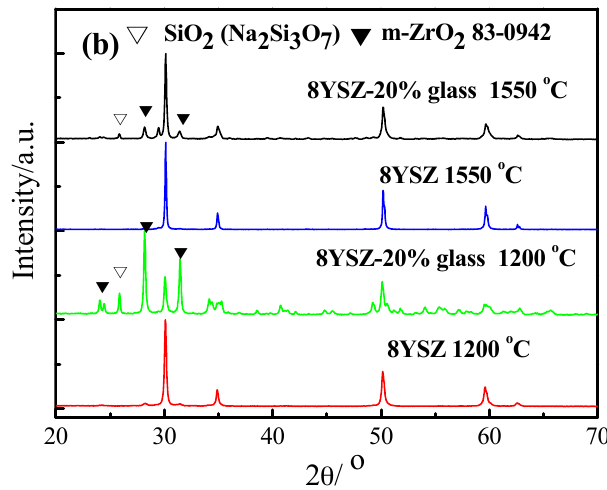
Figure 2. ( a ) XRD patterns of the 8YSZ, 8YSZ-10% glass, 8YSZ-20% glass and 8YSZ-30% glass calcined at 700 °C for 6 h; ( b ) XRD patterns of the 8YSZ and 8YSZ-20% glass calcined at 1200 °C and 1550 °C, respectively.